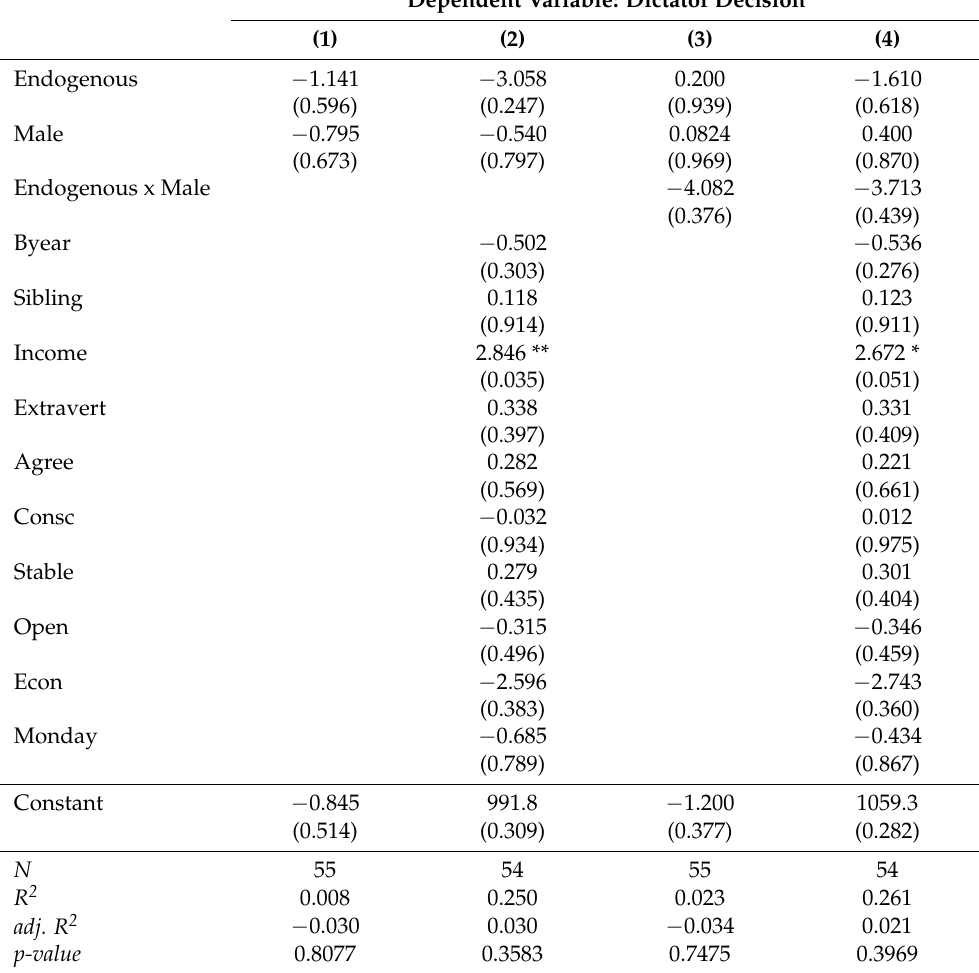
Table 4. OLS results for taking games.